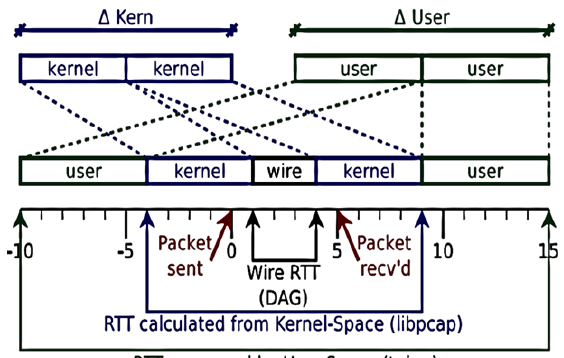
Fig. 3. The measurement of RTT [33].